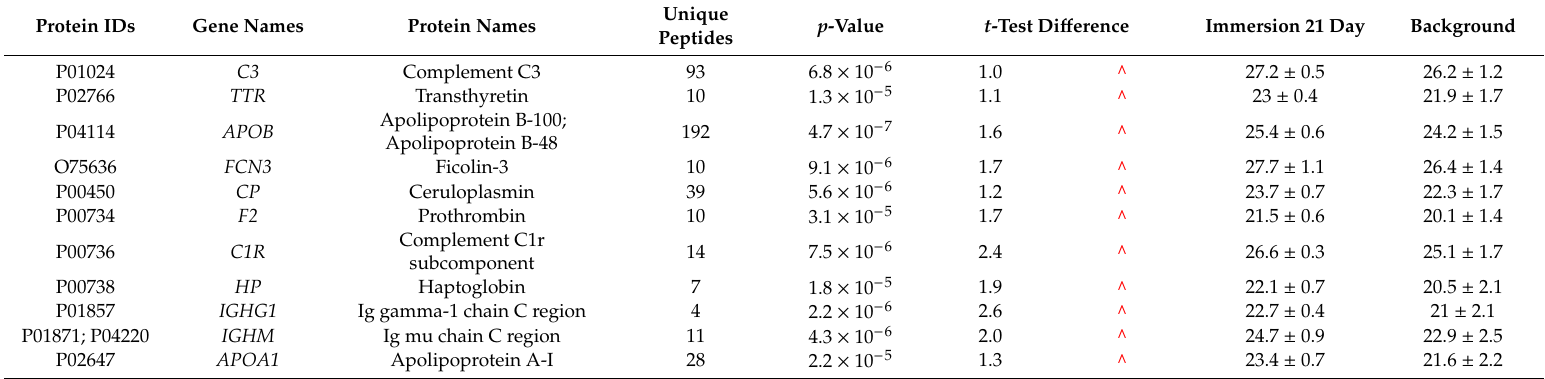
Table 1. The list of proteins significantly changed ( p < 0.01) on the 21st day of the head-down bed rest (HDBR) ground-based experiment with respect to their background levels (the day before the experiment). Proteins were identified by pair-wise comparison (Welch’s t -test). Red/blue symbol—the increase/decrease of the protein level with respect to the background.